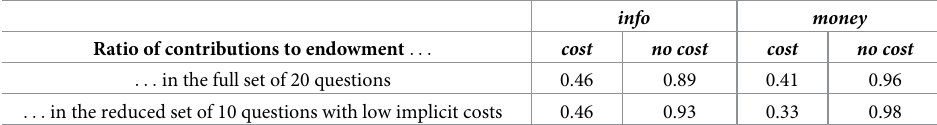
Table 8. Relative provision levels. Ratio of contributions to endowment ...